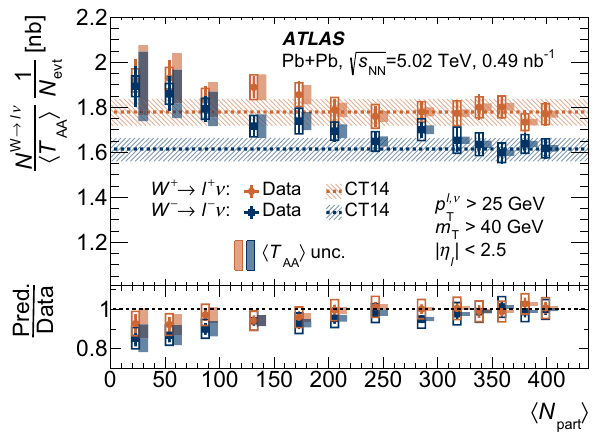
Fig. 12 Normalised production yields of W + and W − bosons as a function of (cid:4) N part (cid:5) shown for the combination of electron and muon decay channels. Predictions calculated using the CT14 NLO PDF set are shown as the horizontal bands. Error bars show statistical uncertain- ties,whereassystematicuncertaintiesareshownastheboxesaroundthe data points. The systematic uncertainties due to (cid:4) T AA (cid:5) are not included in those boxes, and are shown as separate shaded boxes plotted to the right of the data points for better visibility. In the lower panel the ratios of the predictions to the measured yields are displayed, and the boxes around the data points show the sum in quadrature of statistical and systematic uncertainties of the data